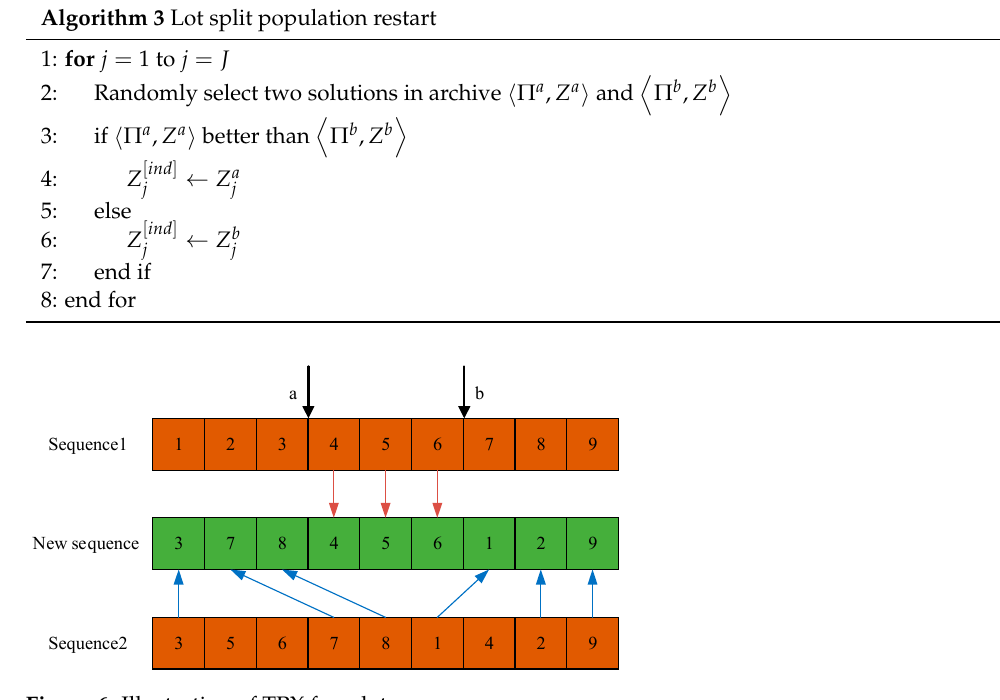
Figure 6. Illustration of TPX for a lot sequence.